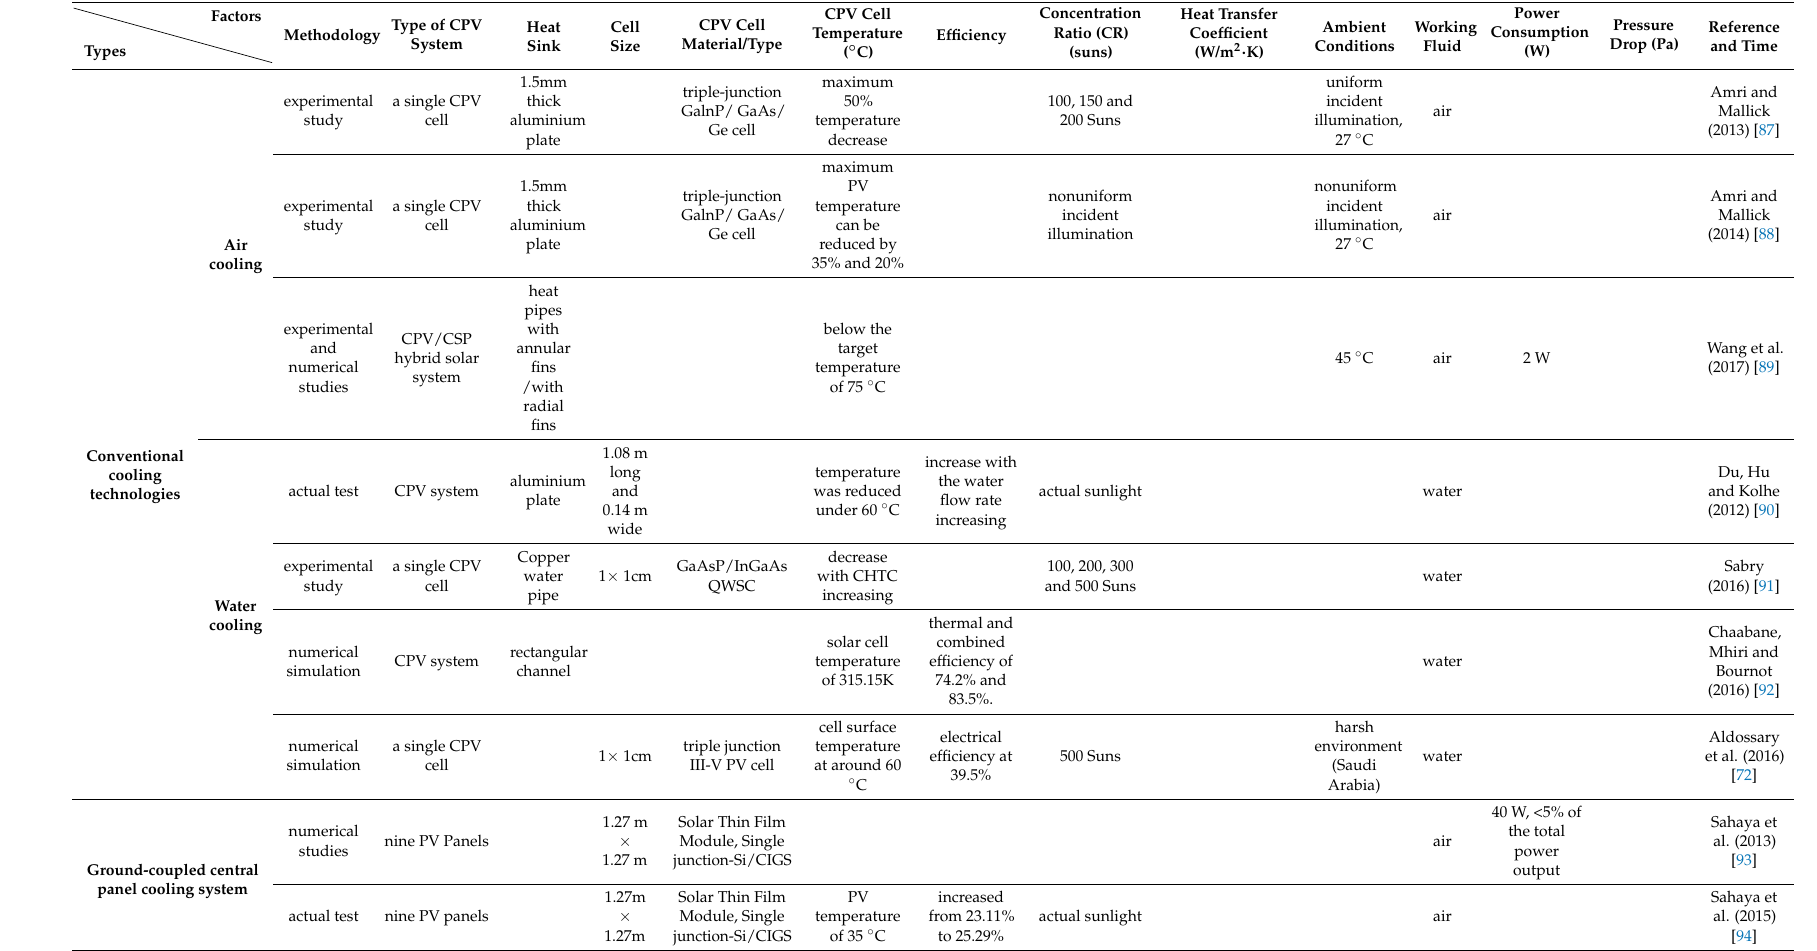
Table 5. Summary of the Active Cooling